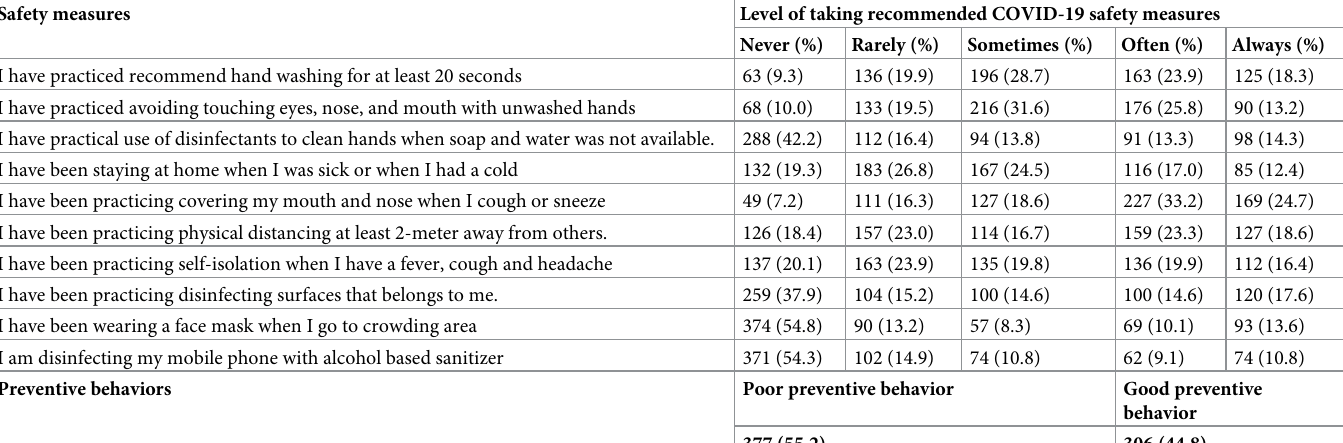
Table 6. Level of adhering to recommended safety measures of COVID-19 among the communities of North Shoa zone, Ethiopia 2020. Safety